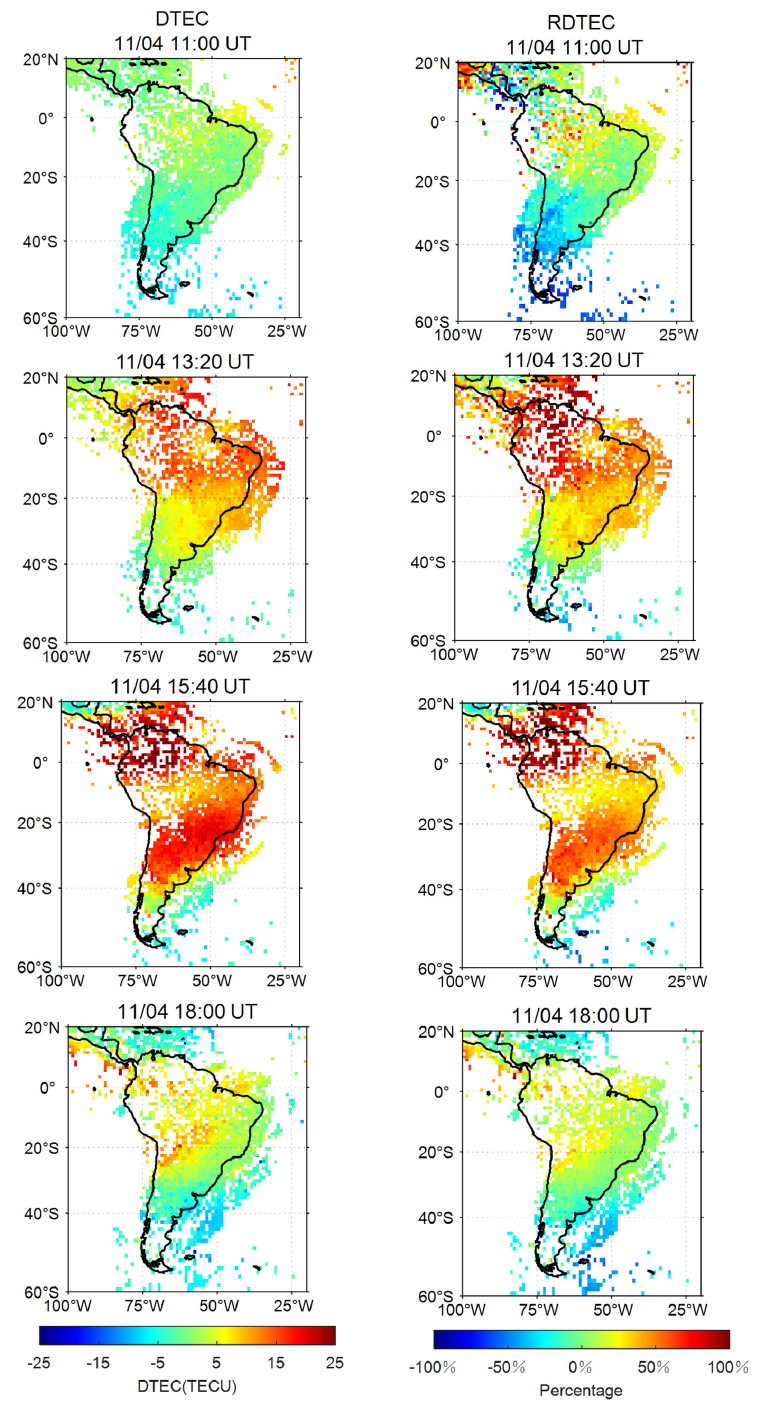
Figure 3. TEC difference (DTEC) and relative TEC difference (RDTEC) distributions over the South American sector between the storm day (4 November) and the quiet day (3 November).